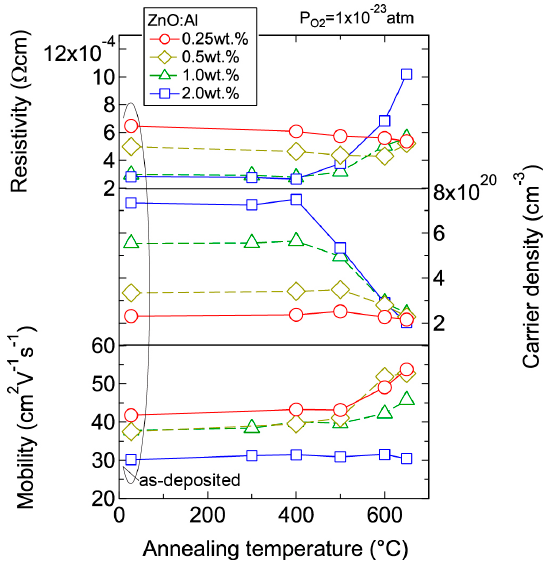
Figure 9. Room-temperature resistivity, carrier density, and mobility in ZnO:Al (0.25, 0.5, 1.0, and 2.0 wt %) films as a function of annealing temperature. Post-annealing was performed at a P O2 of 1 × 10 − 23 atm.